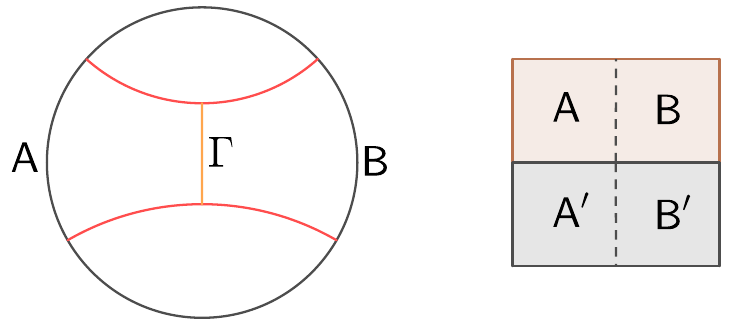
Figure 1 . To the left, (cid:0) is the minimal surface the separates the entanglement wedge cross-section of AB: Its area is E W [ A : B ] : To the right, A 0 and B 0 purify AB: For a choice of A 0 and B 0 over all such purifying systems that minimizes the entanglement across the dashed partition we have E p ( A : B ) = S ( AA 0 )